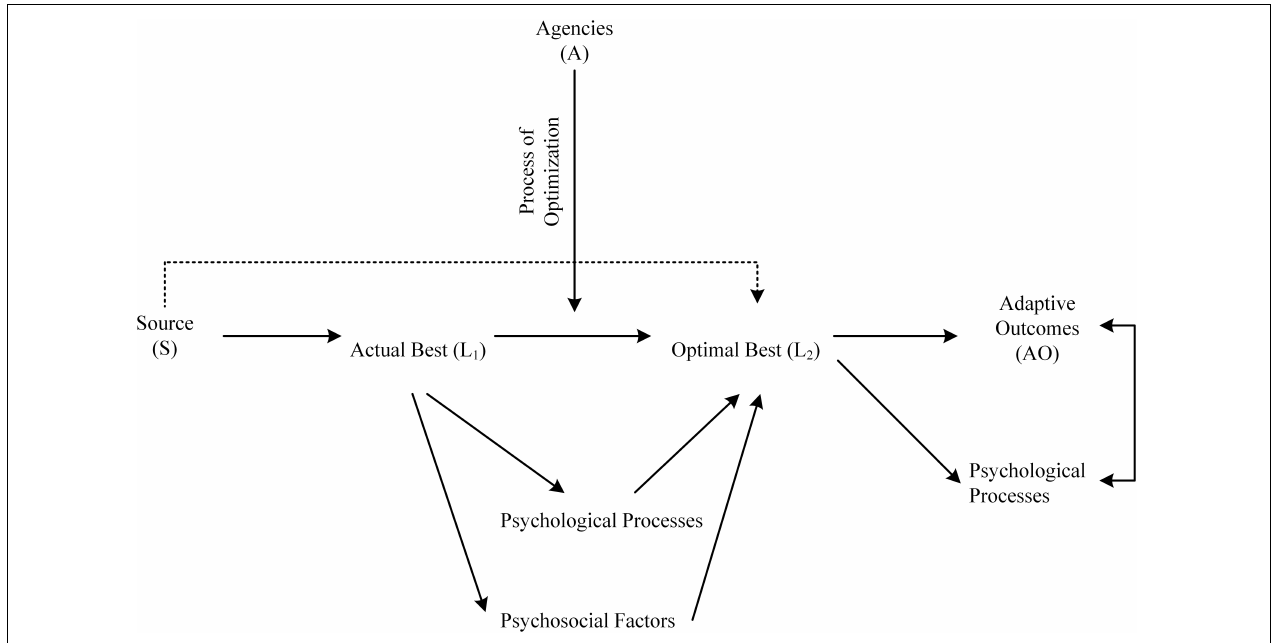
FIGURE 4 | Inquiries of levels of best practice. Adapted from Phan et al. (2019a).